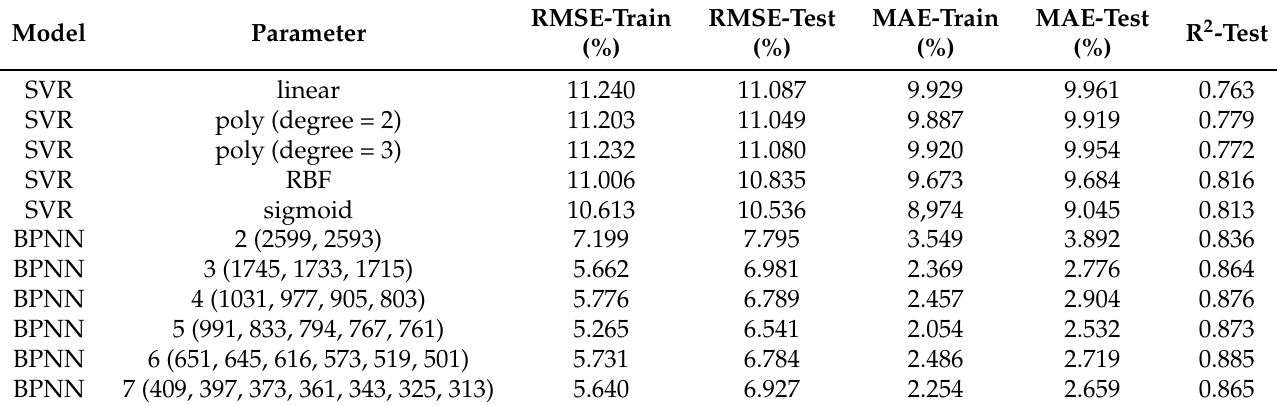
Table 4. Performance of regression models with different parameters on deposition ratio simulation data set.